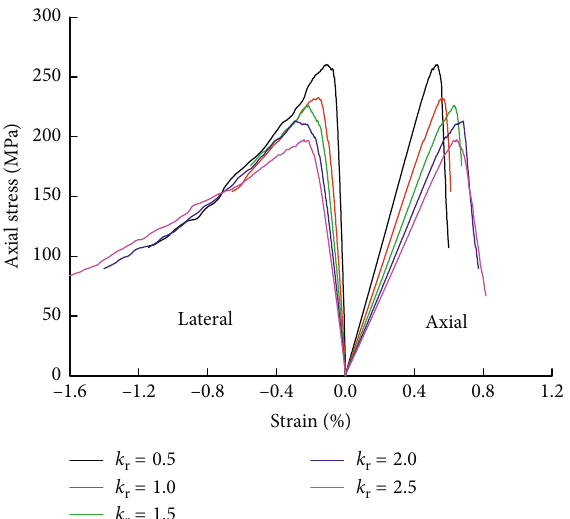
Figure 10: Stress-strain curves from uniaxial compression tests for the different stiffness ratios.